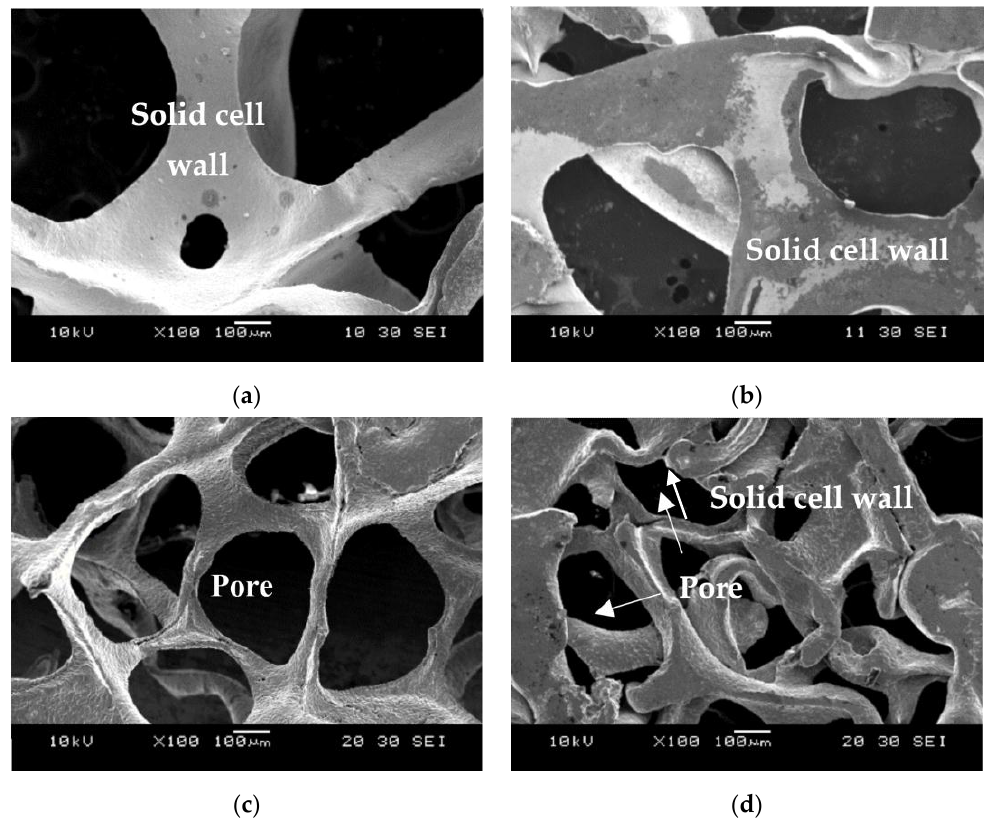
Figure 6. Structure of porous Cu interlayer of P15 and P25 before and after rolling. ( a ) P15, pre-rolled; ( b ) P15, post-rolled; ( c ) P25, pre-rolled; ( d ) P25, post-rolled.